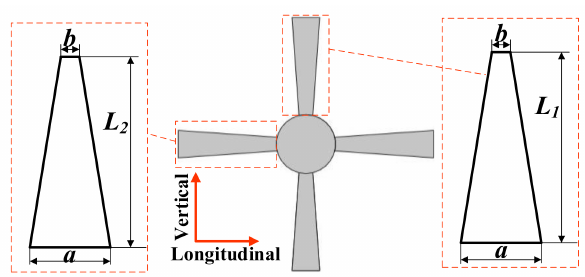
Figure 1. Sketch for the basic quad-trapezoidal-leg orthoplanar spring (QTOPS).